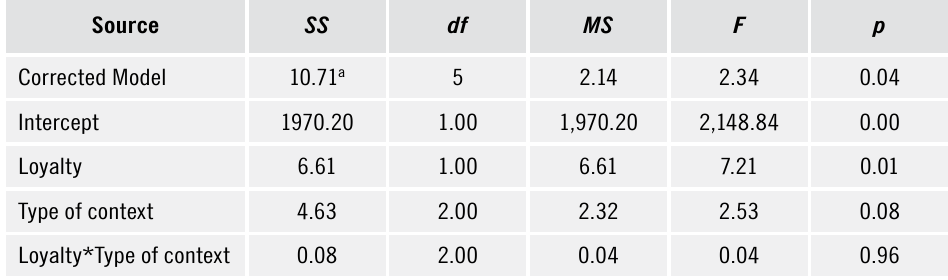
Table 8. Results of 2x3 ANOVA